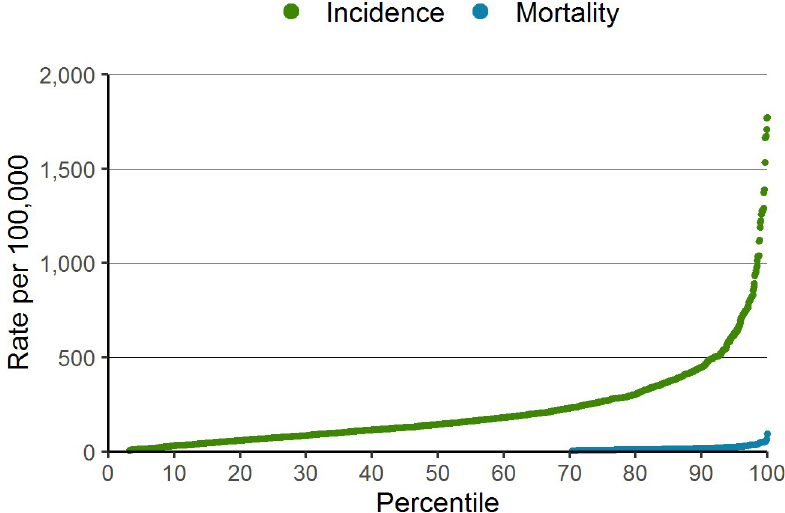
Fig 1. Neighbourhood incidence and mortality rate per 100,000, ranked by neighbourhood